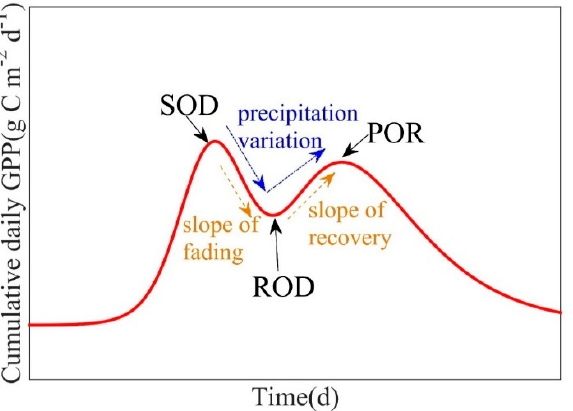
Figure 5. Schematic diagram of summer phenological process after short-term, summer drought. SOD = start of disturb- ance (d), when modeled GPP starts to decline after the spring peak; POR = peak of recovery (d), when modeled GPP reaches peak recovery; ROD = recovery day of disturbance (d).